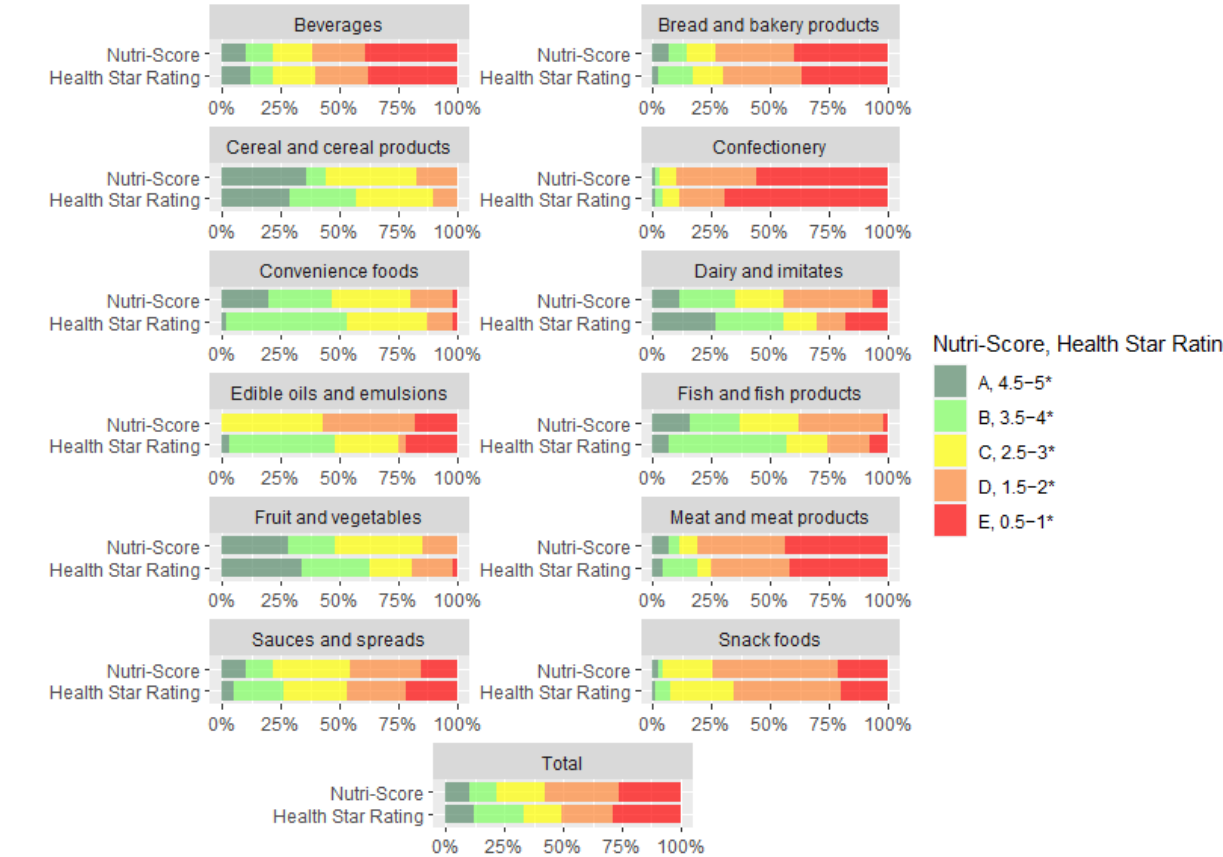
Figure 2. Distribution of Nutri-Score and Health Star Rating grades across main categories. Colours represent different Nutri-Score and Health Star Rating grades. * refers to stars of Health Star Rating grades.